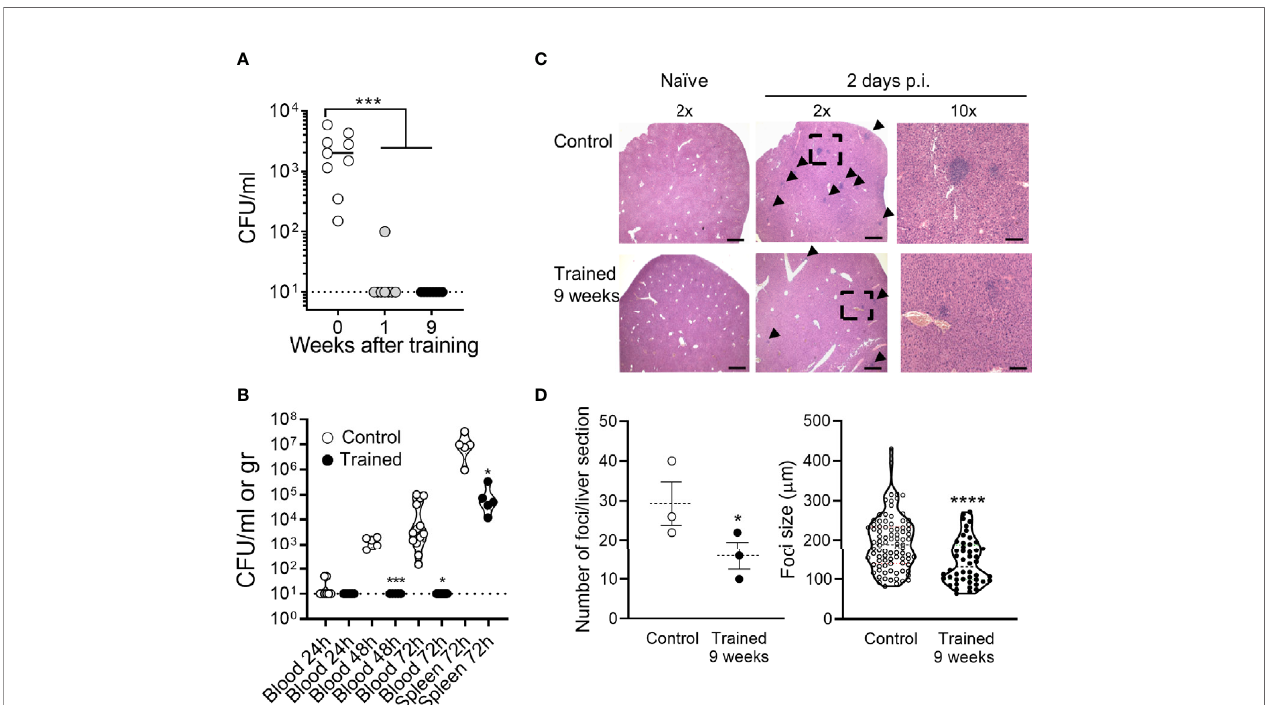
FIGURE 7 | Training for 9 weeks prevents L. monocytogenes burden and dissemination. Control mice and mice trained 1 week or 9 weeks before infection were challenged i.v. with 1.5-2 x 10 4 CFU L. monocytogenes . (A) Blood was collected 2 days p.i. to quantify bacteria. Each dot represents a mouse ( n = 9, 8 and 8, for mice trained for 0, 1, or 9 weeks, respectively). The plain and dotted horizontal lines represent median and limit of detection, respectively. (B) Blood and spleen were collected 1-3 days p.i. to quantify bacteria. Each dot represents a mouse (n = 4-13). The plain and dotted horizontal lines represent median and limit of detection, respectively. (C, D) Livers ( n = 3 control mice and 3 mice trained 9 weeks) were collected 2 days p.i. and liver sections stained with hematoxylin and eosin. (C) Representative images of liver sections imaged at 2x and 10x magni fi cation using an EVOS M7000 microscope. Scale bar represents 750 µm or 150 µm for 2x and 10x magni fi cation images, respectively. Arrows point to foci and the doted square to the area zoomed 10x. (D) Number of foci per liver section and size of foci. * P < 0.05; *** P < 0.001; **** P < 0.0001 vs. control.